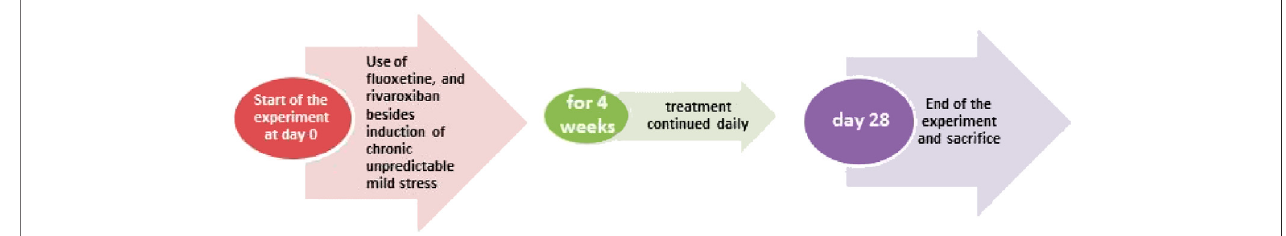
FIGURE 1 | Diagrammatic scheme of the experimental